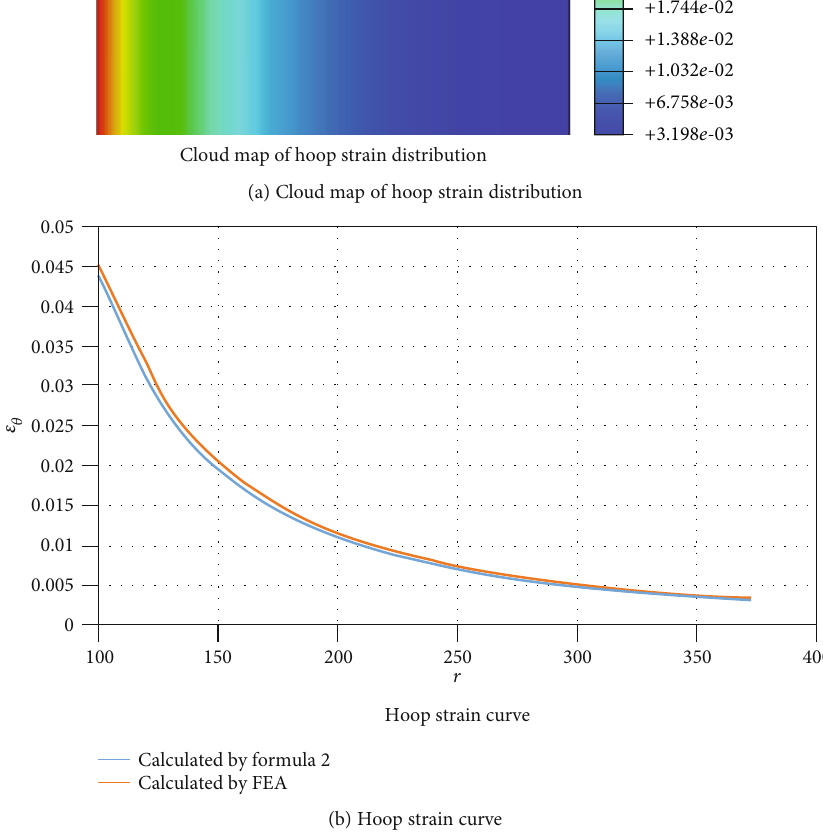
Figure 3: The result of the hoop strain